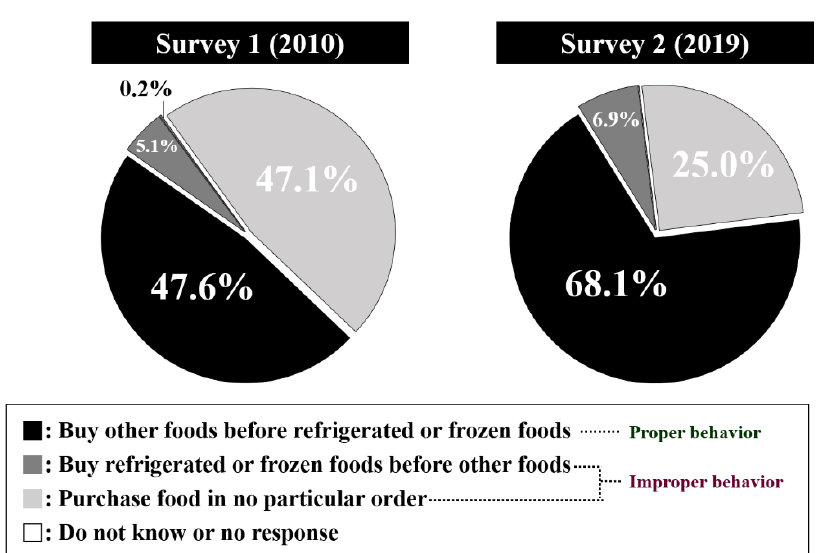
Figure 2. Consumers’ risk perceptions of the proper food purchasing order: ( a ) foods and nonfoods ( b ) refrigerated/frozen foods and foods that can be stored at room temperature.